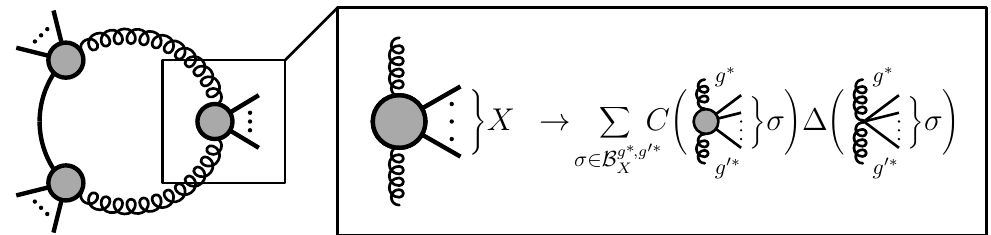
Figure 4 . Inserting a gluon-gluon stretch tree basis into coloured cuts of a one-loop